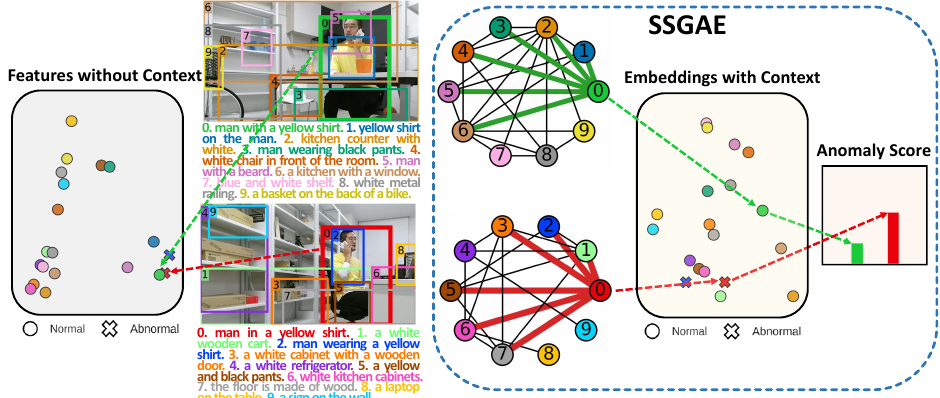
Figure 8. Example of detecting anomalous regions by